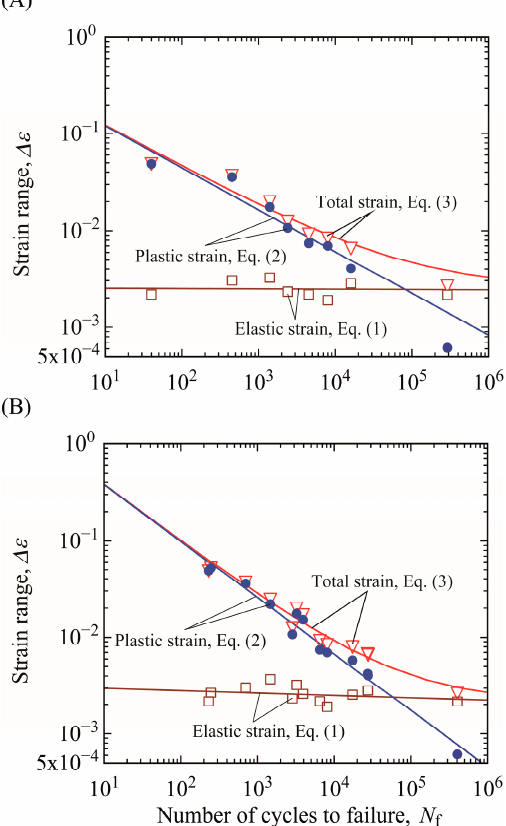
Figure 9. Strain-based approach for bending testing ( t = 5 mm): ( A ) crack initiation life, and ( B ) total failure life.